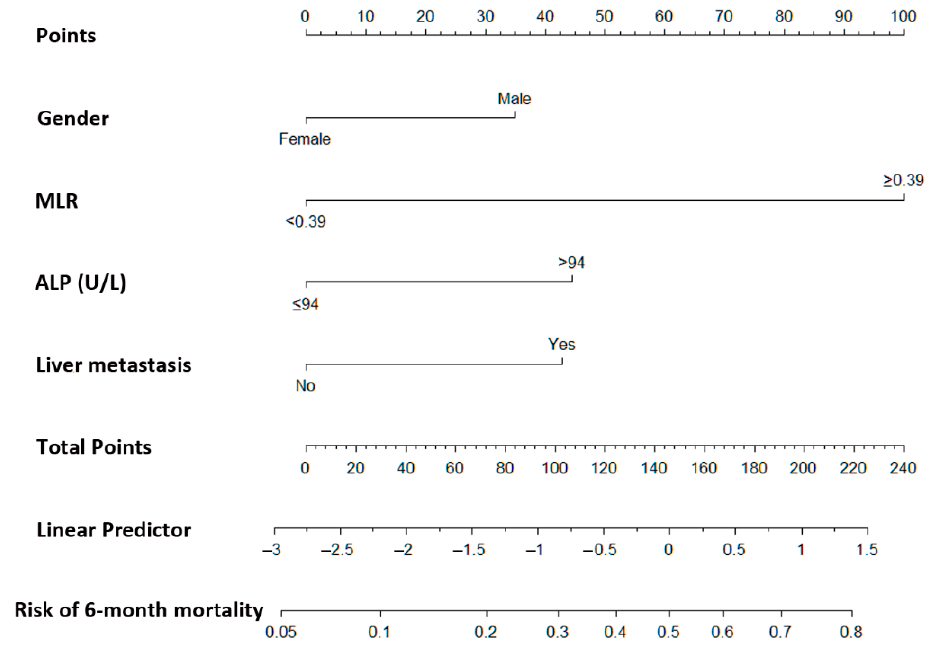
Figure 2. A nomogram was generated to predict the 6-month mortality rate of patients with biliary tract cancer undergoing gemcitabine-based chemotherapy. MLR, monocyte to lymphocyte ratio; ALP,